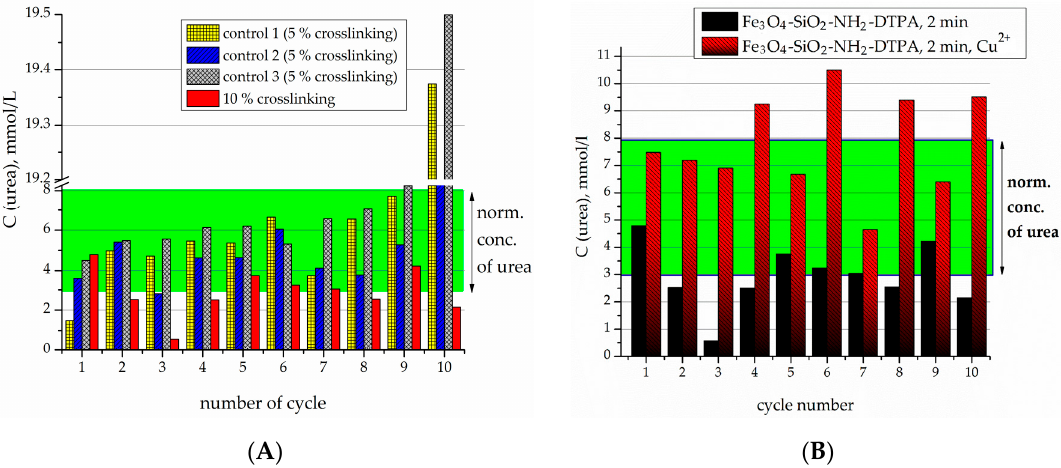
Figure 6. Hydrolysis of pathologic concentration of urea in the isotonic buffer by: ( A ) Fe 3 O 4 /SiO 2 -NH 2 -DTPA-Urease nanocomposite, 5, 10% crosslinking by glutaraldehyde; contact time: 2 min; ( B ) Fe 3 O 4 /SiO 2 -NH 2 -DTPA-Urease nanocomposite, 10% crosslinking by glutaraldehyde; C (Cu 2+ ) = cycle number × 0.1 µmol; contact time: 2 min.